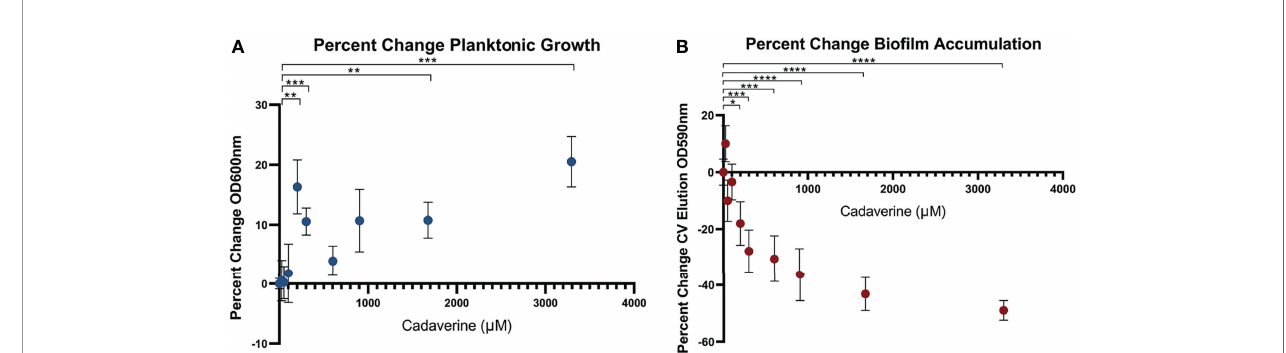
FIGURE 5 | Microtitre plate assays show cadaverine supplementation signi fi cantly increases planktonic growth and decreases bio fi lm accumulation post inoculation. Planktonic growth (A) and bio fi lm accumulation (B) are measured by OD 600 and crystal violet staining elution at OD 590 , respectively, after supplementation of 0-3.30mM cadaverine to the growth media for 24 hrs (n=18). Values are normalized to the control wells (no cadaverine) in each plate and reported as a percent change from control and asterisks denote signi fi cance (* p < 0.05, ** p < 0.01, *** p < 0.001, **** p < 0.0001 by unpaired, two-tailed t -test). (A) Planktonic growth signi fi cantly increases at several cadaverine concentrations, maximally by 21%. (B) Bio fi lm accumulation signi fi cantly decreases in a cadaverine concentration dependent manner, maximally